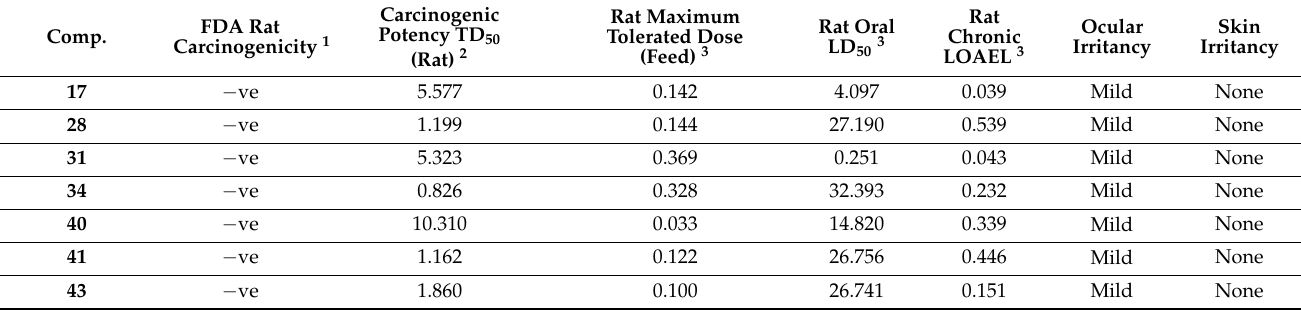
Table 4. Toxicity properties of tested compounds and S88 .